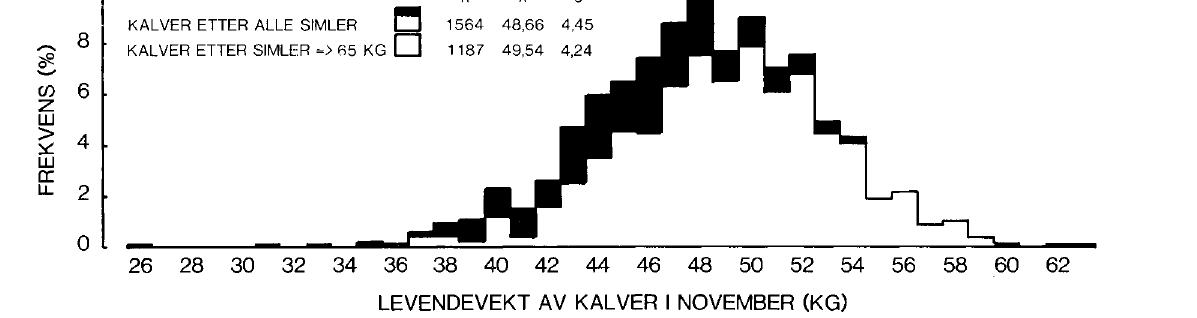
Figur 14. Vekt av kalver i Riast/Hylling-flokken i november 1984. Antall kalver innen vektklasser på hele kilo er angitt. Svart del markerer kalver etter mødre som er lettere enn 65 kg (Lenvik upubll). (1984) i Riast/Hylling-flokken. Denne simle- flokken ble omstrukturert fra modell B til mo